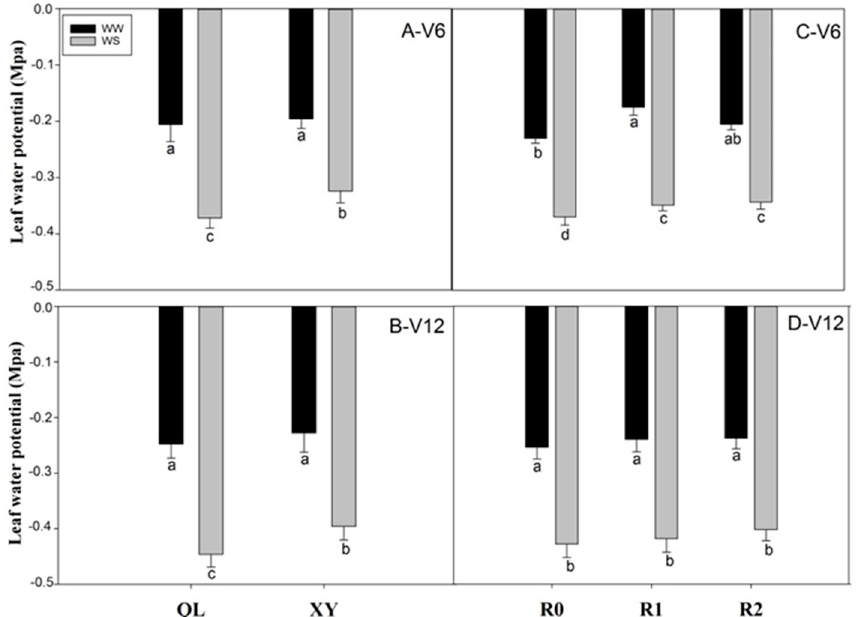
Figure 3. Leaf water potential at the jointing stage ( A − V6) and at anthesis stage ( B − V12) in Experiment 1. Leaf water potential at the jointing stage ( C − V6) and at anthesis stage ( D − V12) in Experiment 2. Values are means ± standard error ( n = 5). Different letters indicate significant differences among treatments ( p < 0.05) based on Duncan’s test. The treatment abbreviations are defined in Figure 1.